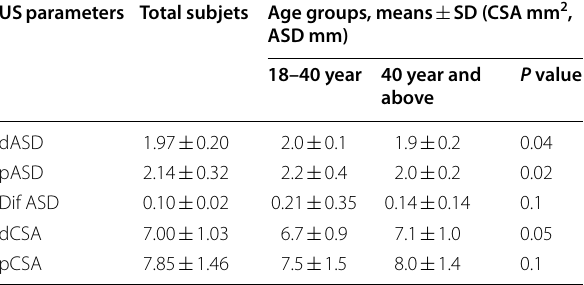
ASD anterosuperior diameter, d distal, p proximal, ASD diff anterosuperior diameter difference, CSA cross‑sectional area, mm , millimeters